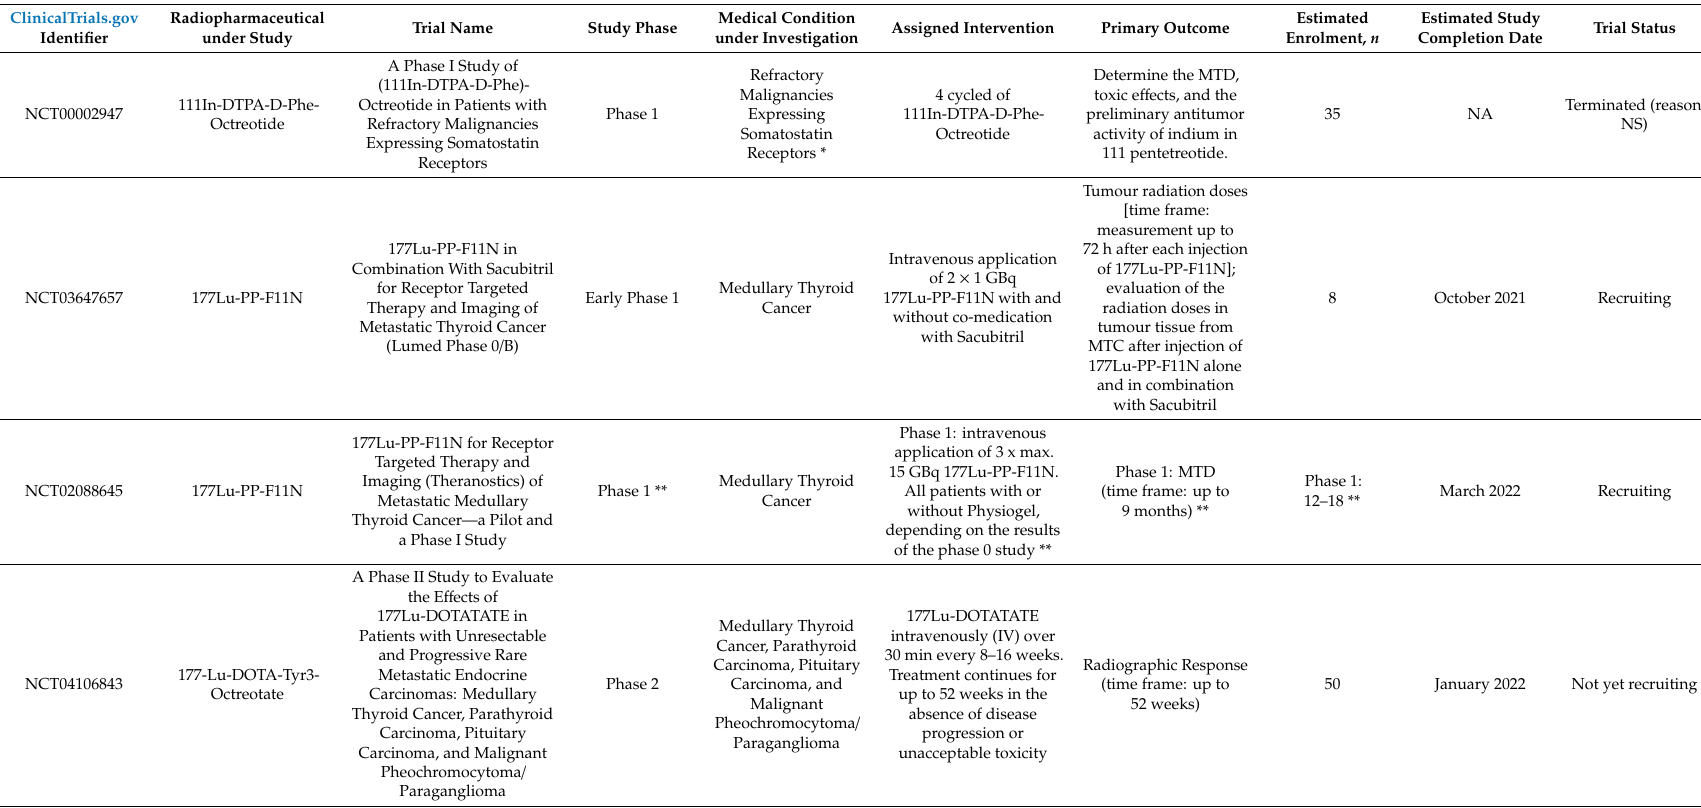
Table 4. PRRT targeting SSRs and CCK2Rs in MTC: registered clinical